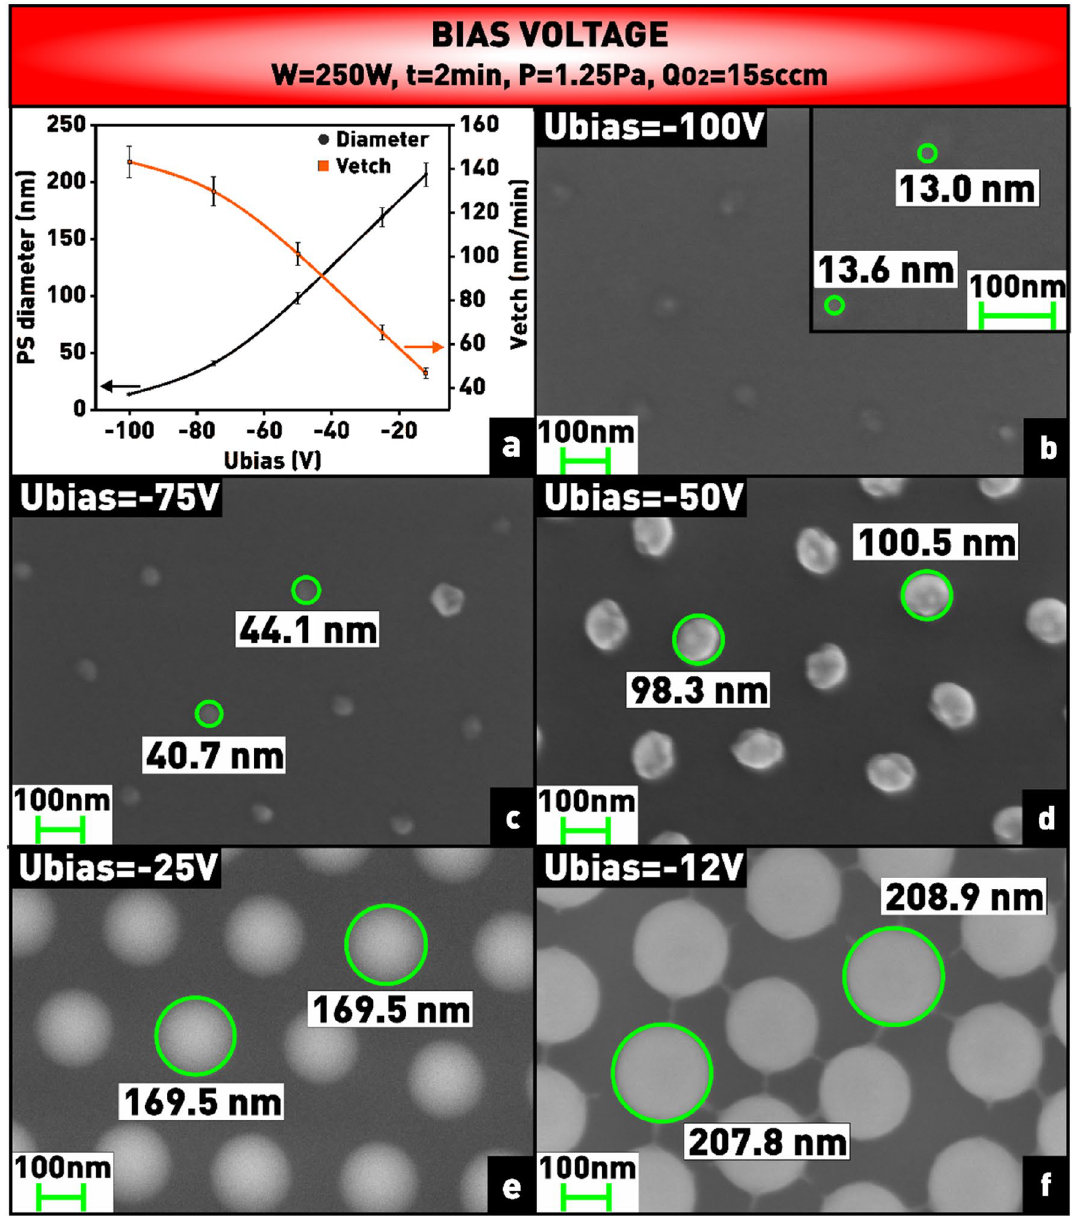
Figure 12. (a) Plot of dependence of nanosphere diameter and etching rate on bias voltage on the substrate holder; (b–f) microphotographs of nanosphere mask obtained at varying bias